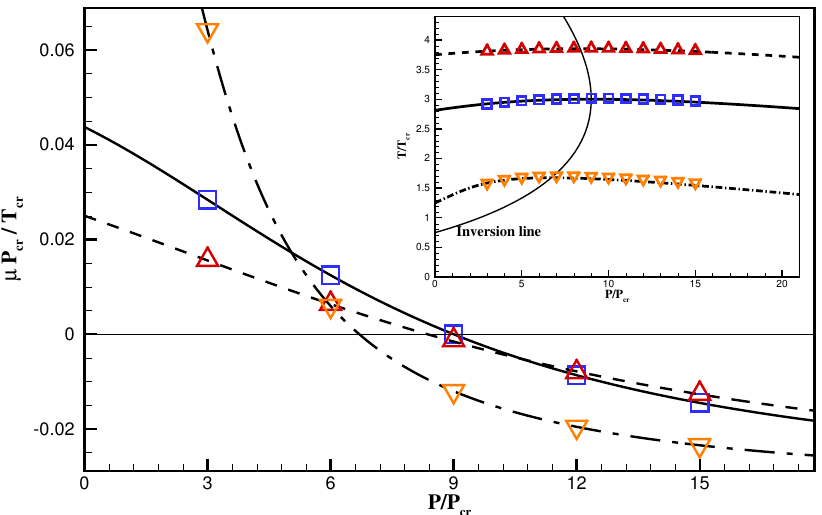
Figure 2. Joule-Thomson coefficient against reduced pressure. The value of the Joule–Thomson coefficient along the dimensionless isenthalpic lines ˆ h = h / RT cr was measured in a wide range of reduced pressures up to P / P cr = 15. Line: Theory; Solid: ˆ h = 11.25; Dashed: ˆ h = 15; Dash dot: ˆ h = 5. Symbols: Present method; Squares: ˆ h = 11.25; Triangles: ˆ h = 15; Inverted triangles: ˆ h = 5. Inset: Simulated lines of constant enthalpy on the T r − P r (phase)